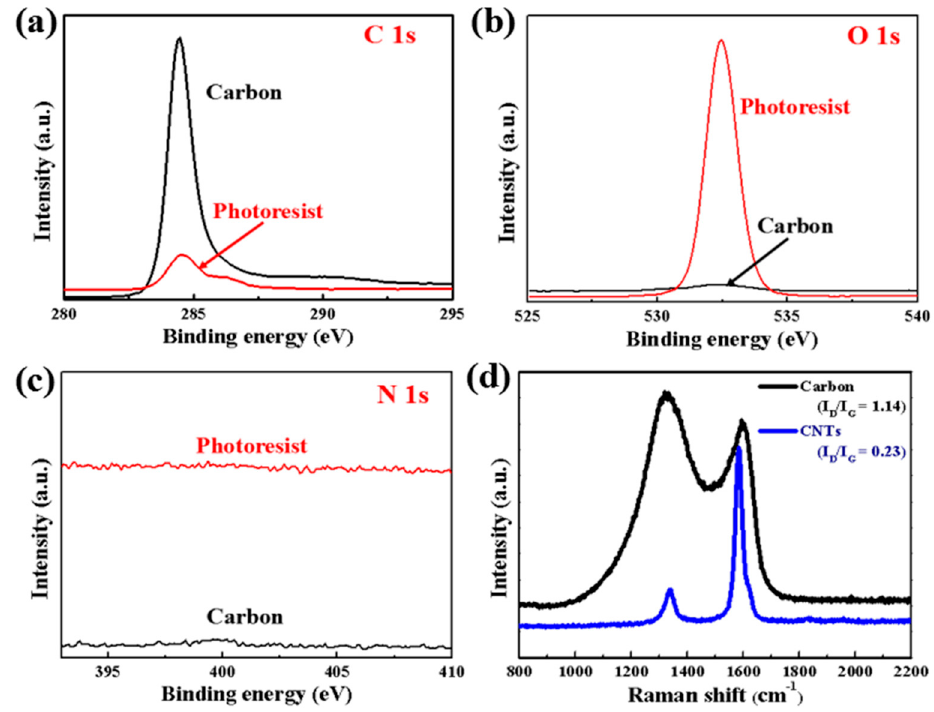
Figure 2. ( a – c ) XPS curves of GM-1060 photoresist and pyrolyzed carbon. ( d ) Raman spectra of pyrolyzed carbon and